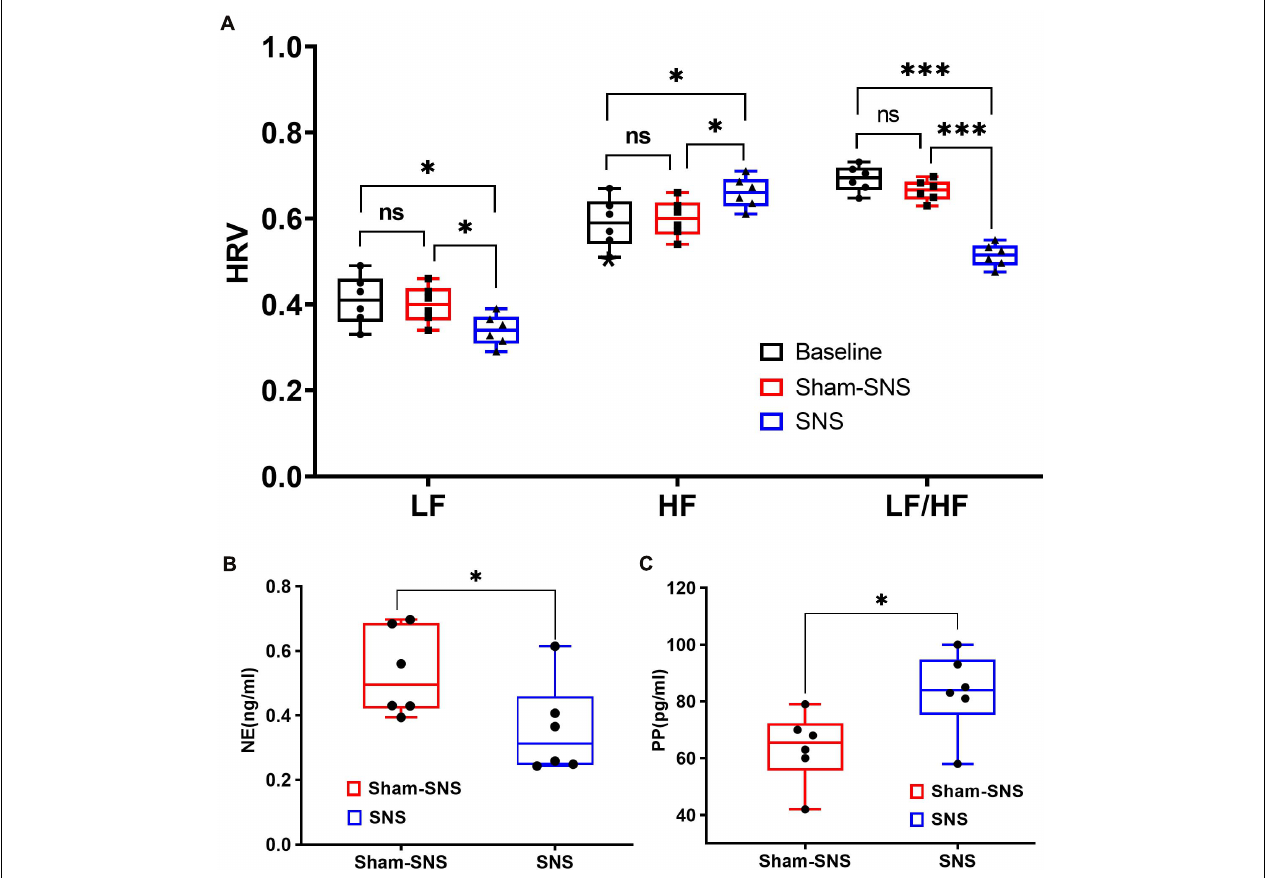
FIGURE 4 | Effects of chronic SNS and sham-SNS on autonomic functions. (A) Upper panel shows the effects of chronic SNS and sham-SNS on vagal and sympathetic activities of visceral hypersensitive rats. HF and LF were measured by heart rate variability derived from ECG recording. HF (0.8–4.0 Hz) represents vagal activity, while LF (0.3–0.8 Hz) represents sympathetic activity. LF/HF ratio reflects the balance between sympathetic and vagal activity. Chronic SNS (but not sham-SNS) for 2 h/day for 14 days, significantly increased vagal activity (HF) and decreased sympathetic activity (LF) and the balance between sympathetic and parasympathetic activity (LF/HF) (ns: not significant, * p < 0.05, *** p < 0.001; One-Way ANOVA, Tukey). The unit for both LF and HF was the decibel. (B,C) Lower panel show the effects of chronic SNS on endocrine hormones NE and PP before and after treatment. (B) Represents the endocrine hormone NE showing the level of sympathetic activities in SNS and sham-SNS groups. (C) Represents the endocrine hormone PP showing the level of vagal activities in SNS and sham-SNS groups. NE and PP dramatically changed after 3-week SNS treatment compared to sham-SNS (all significantly changed; * p < 0.05; Student t -test). Values were represented as the means ± SE ( n = 6). Baseline: represents HRV before treatment initiation. SNS, sacral nerve stimulation; HRV, heart rate variability; HF, high frequency; LF, low frequency; NE, norepinephrine; PP, pancreatic